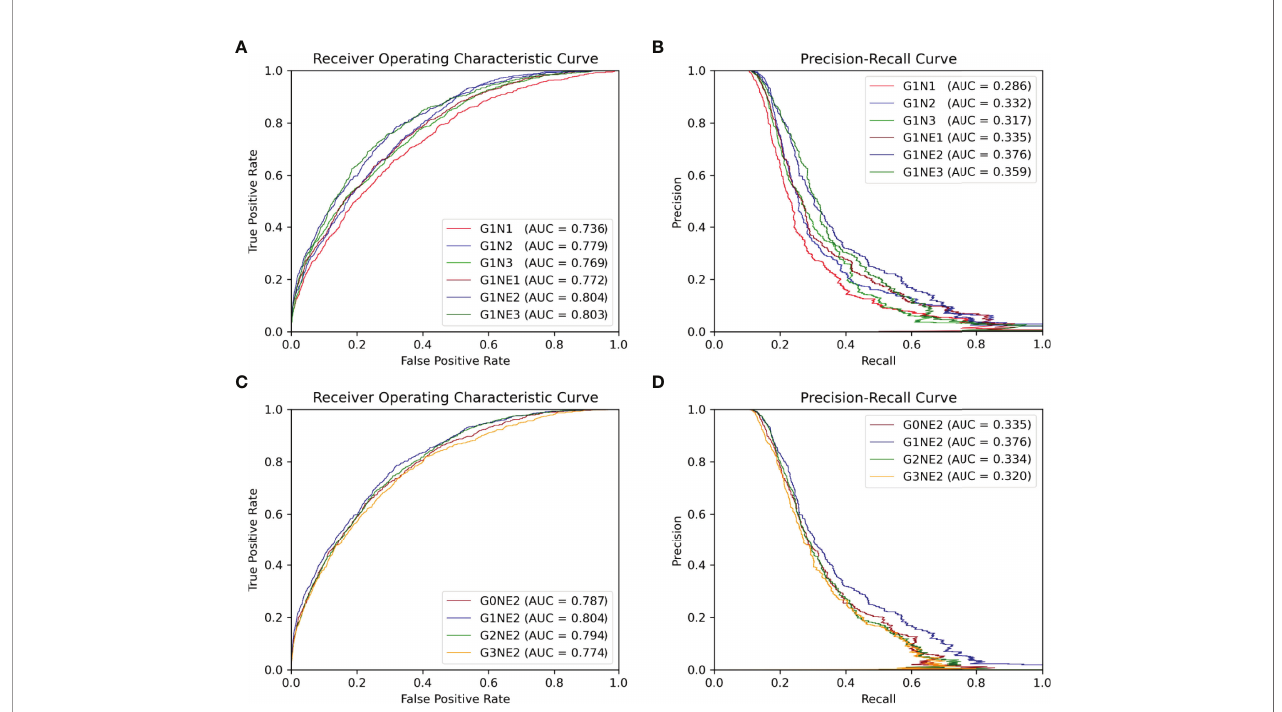
FIGURE 4 | ROC and PR curve of different network combinations among all antigen residues in the testing set. (A, B) ROC and PR curve using different networks processing local features. (C, D) ROC and PR curve of the using different networks processing gobal